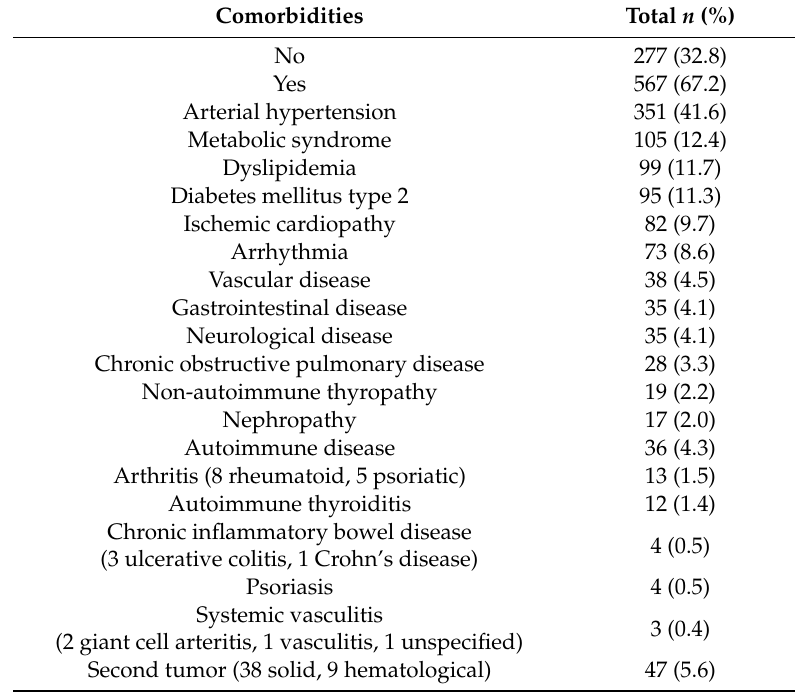
Table 2. Baseline comorbidities of CRPC patients treated with abiraterone or